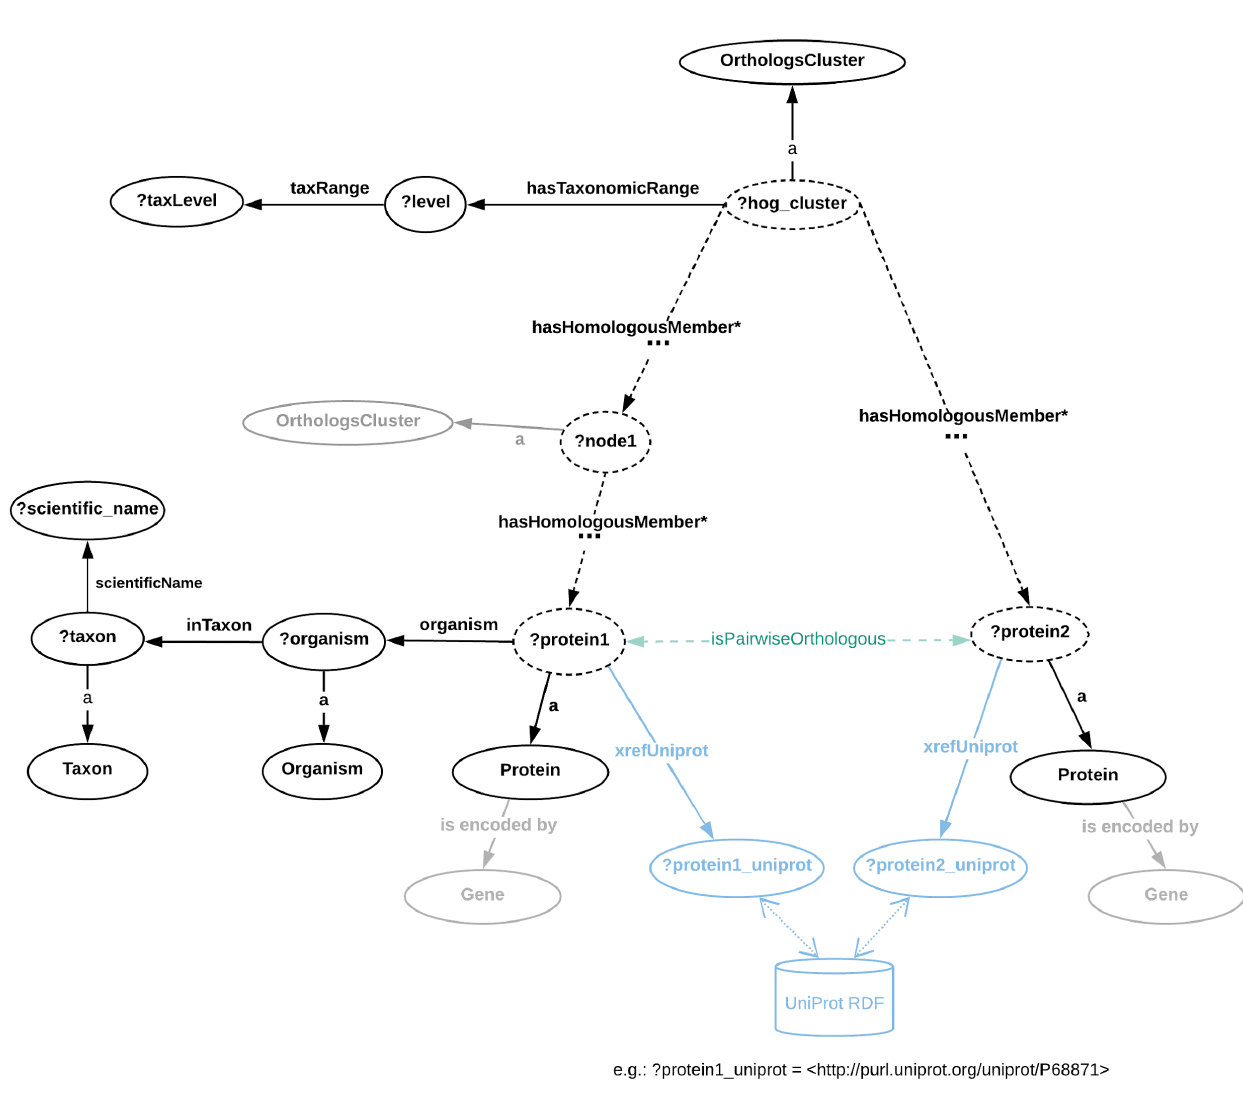
Figure 4. Directed graph abstraction of a portion of the OMA RDF graph related to hierarchical orthologous groups. In Figure 4, dashed edges illustrate the orth:hasHomologousMember property that can be stated zero or more times, recursively. OMA is protein- centric, however the corresponding genes that encode the proteins are also available in RDF through the “is encoded by” property (a cross-reference to Ensembl identifiers is also provided). Furthermore, the taxonomic ranges where HOGs were built are asserted through the “hasTaxonomicRange” property. The pairwise orthology information is not directly available (e.g. through an RDF property), but can be extracted from the Orthologs Cluster (to highlight this, the “isPairwiseOrthologous” is shown in green with a dashed arrow). Note: URI prefixes were